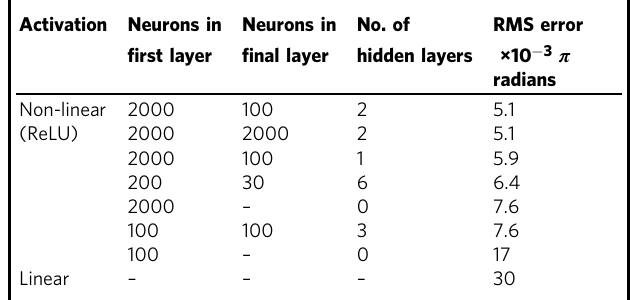
Table 1 The performance of several different neural network architectures (selected from a larger hyperparameter scan) in predicting the incident wavefront error from the 19 PL output fl uxes, quanti fi ed by the root-mean-squared-error (in π radians) of the predictions using test data. A deep, funnel- shaped network gives the lowest error. The ability of a neural network to handle non-linearity is clearly advantageous. See text for details.